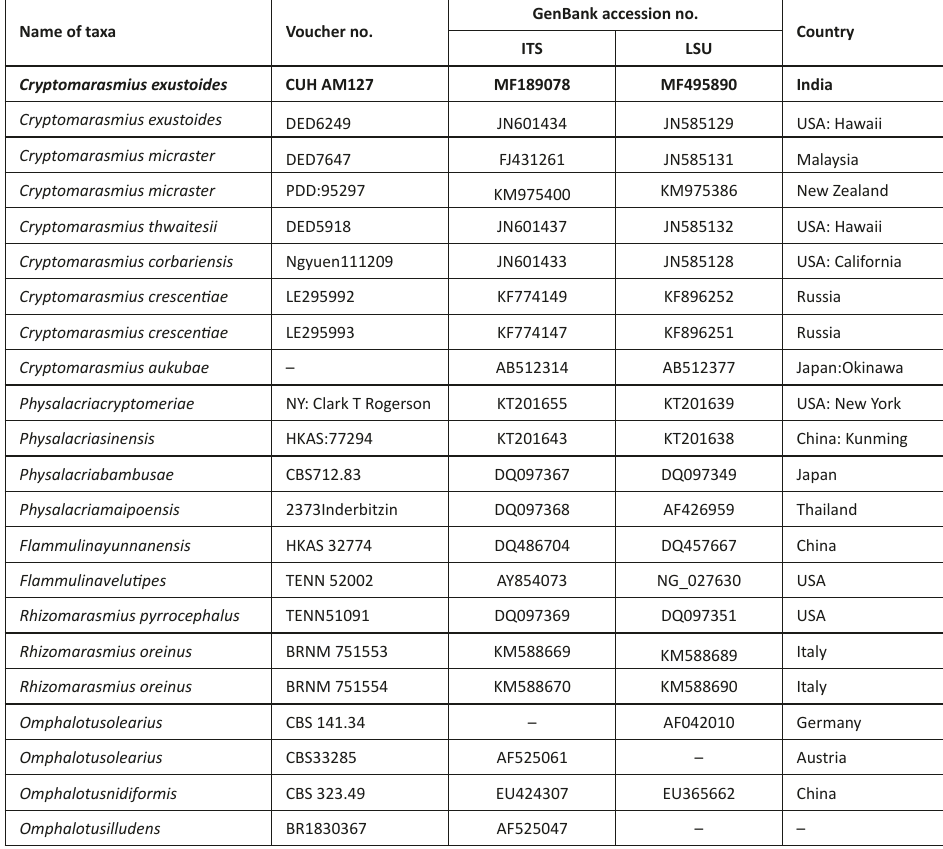
Table 1. Fungal species and GenBank accession number for the sequences used in the phylogenetic analysis. Bold font represents the newly sequenced